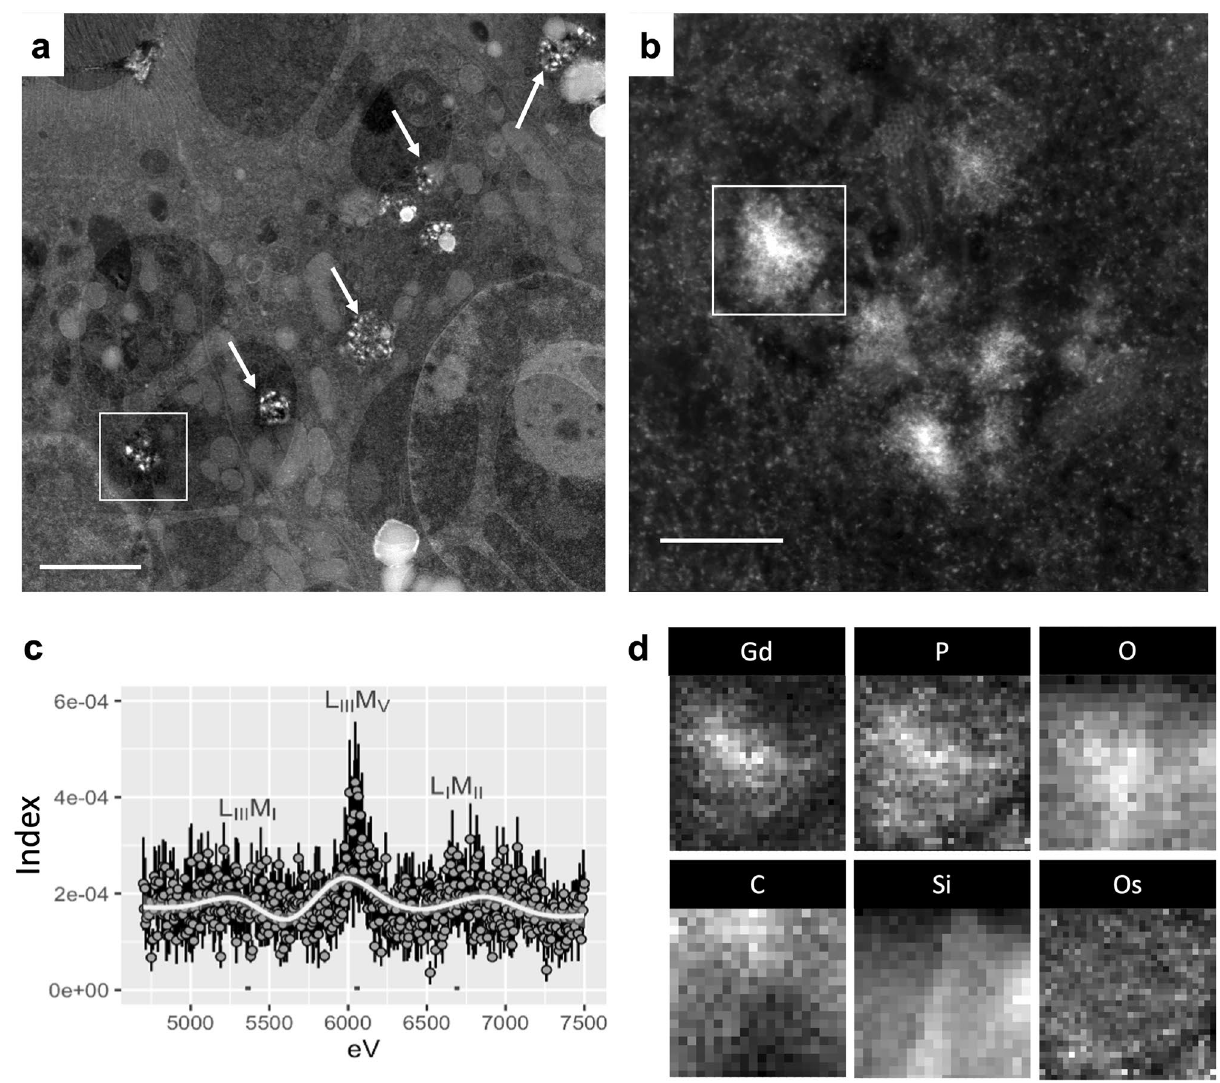
Figure 5. MRI contrast agent-induced nanoparticles are gadolinium rich. Renal cortex was analyzed from a MRI contrast agent-treated mouse. ( a ) Intracellular electron-dense spiculated nanoparticles pepper renal tubular cells (arrows). Bar = 2 μm. ( b Magnified region from ( a ) showing an intracellular cluster of electron- dense, sea urchin-shaped precipitate. Bar = 200 nm. ( c ) XEDS data of the precipitate, gadolinium L energy range (L III M I , 5.362 eV; L III M V , 6.058 eV; and L I M II , 6.690). The L electron shell energies are far from those of physiologic elements, lending these signals to be specific for gadolinium 18 . Mean ± SE, n = 4 individual precipitates. ( d ) 2-dimensional (2D) XEDS map for gadolinium (Gd), phosphorus (P), oxygen (O), carbon (C), silicon (Si), and osmium (Os) of the electron-dense nanostructure featured in panel ( b ). Tecnai F30 300kv transmission electron microscope equipped with an EDAX